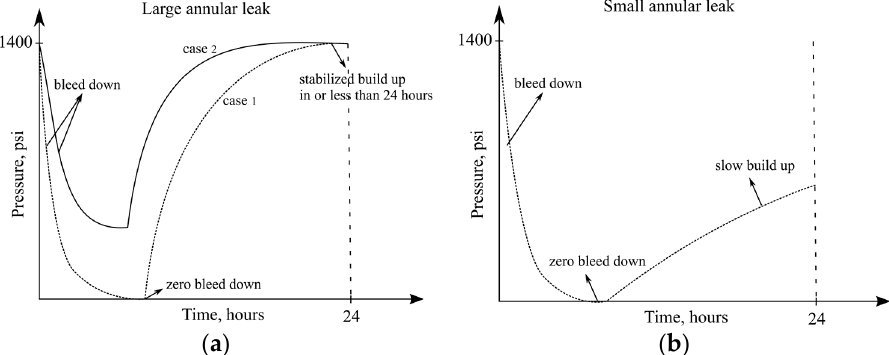
Figure 1. ( a ) Large leak Case 1 (long column of viscous fluid)—casing pressure bleeds down to zero; Case 2—non-zero pressure bleed down; Pressure rebuilds quickly for both cases ( b ) Small leak;